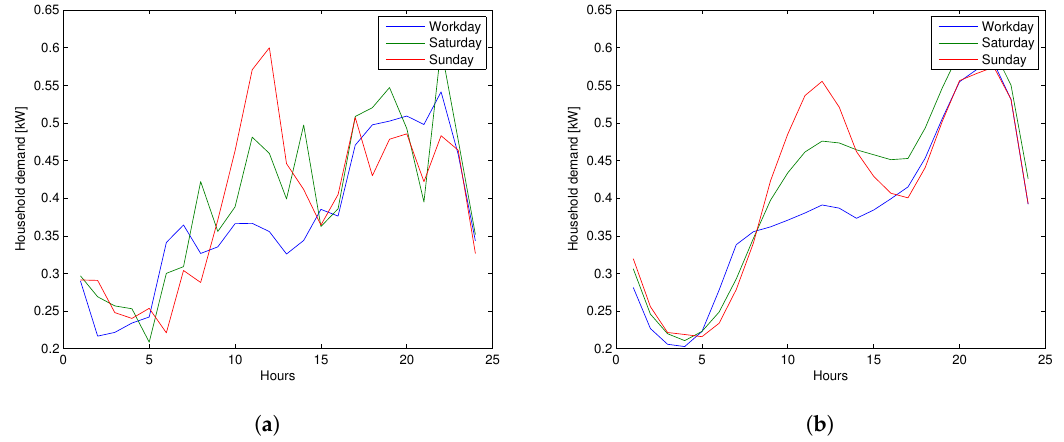
Figure 5. Household curves for three representative days of the autumn week: (i) Workday, (ii) Saturday and (iii) Sunday. ( a ) Household-Measured; ( b ) Household-Equivalent Load.